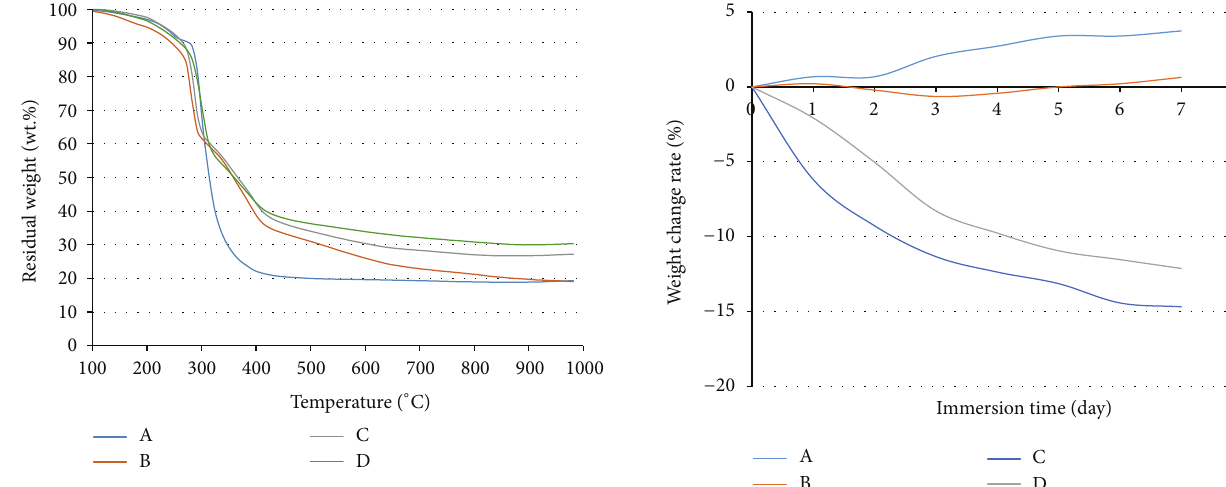
Figure 4: TGA curves of samples A, B, C, and D.